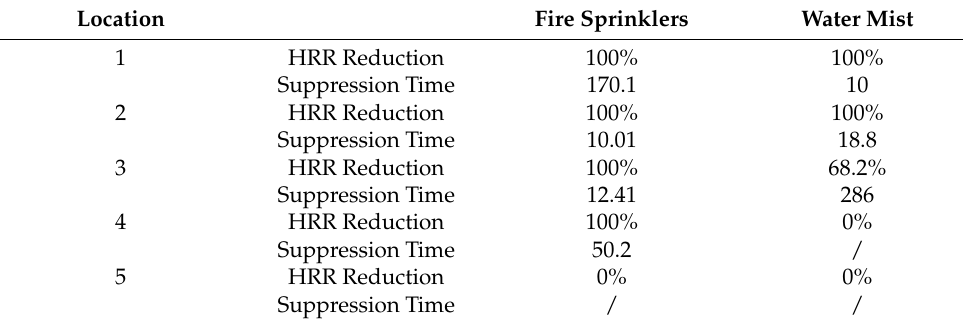
Figure 5. Comparison of HRR Profiles; ( a ) Fire Sprinkler ( b ) Water mist. Table 2. Fire suppression reflected by HRR reduction for both